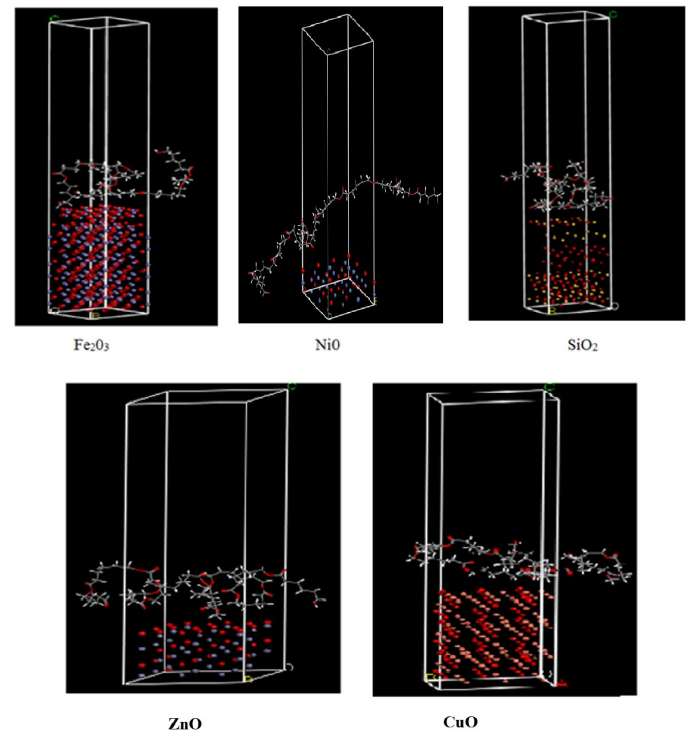
Figure 1. PCL simulated structure with metal oxides(optimized).